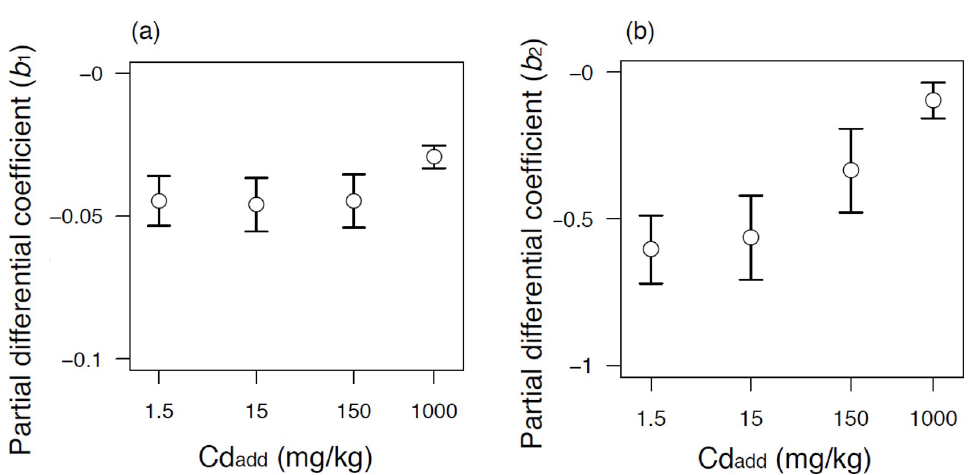
Fig 6. Partial differential coefficients of (a) CEC and (b) pH for different values of [Cd Add ] in Eq 8. Error bars represent standard error of the estimates (N = 17).